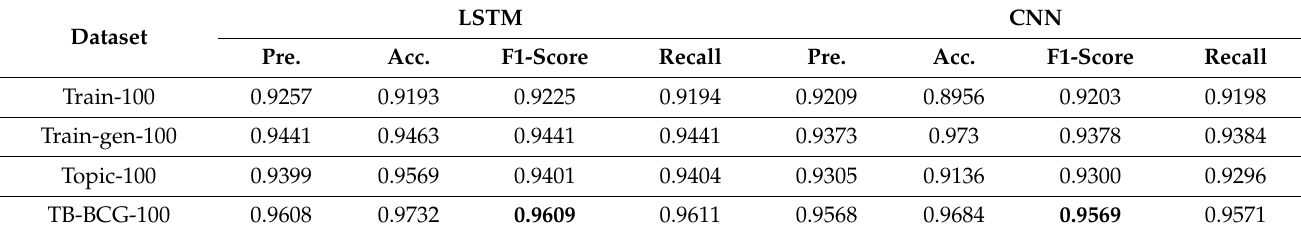
Table 10. Experimental result of 100%